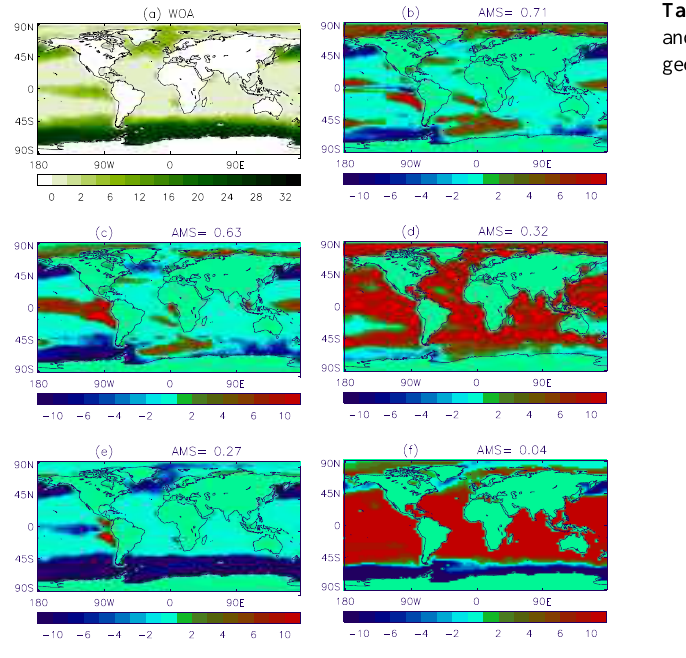
Fig. 9. Annual mean nitrate concentration in mmol per m − 3 at 5m for (a) World Ocean Atlas observations (Garcia et al., 2006) and (b–f) 5 ensemble members with AMS scores varying between the maximum and minimum for the perturbed physics ocean ensemble.